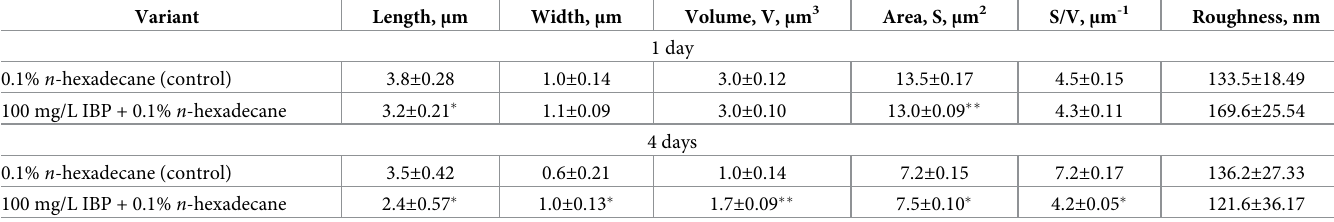
Table 7. Morphometric parameters of R . cerastii IEGM 1278 cells grown in the RS medium supplemented with IBP and n -hexadecane. Variant